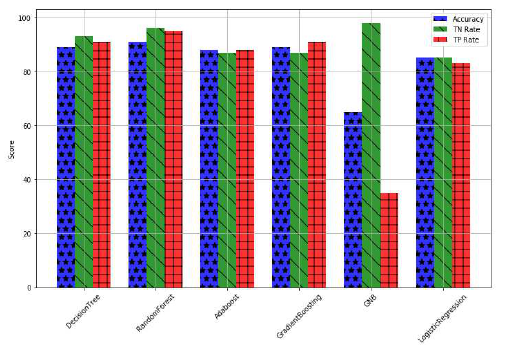
Fig 3. Classification Results for 6